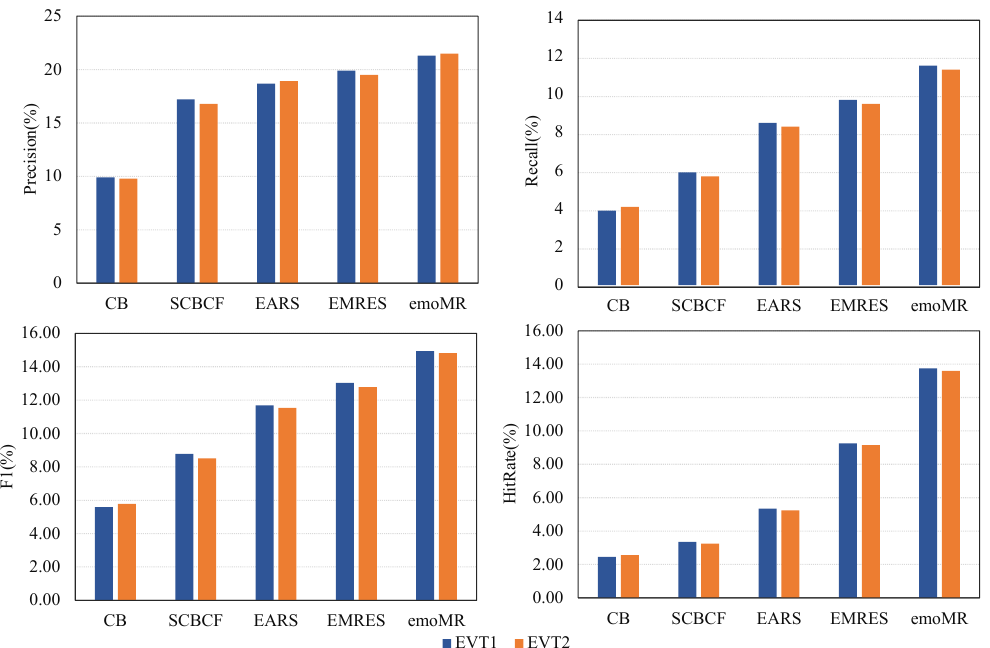
Figure 11. The performance comparison of the methods in recommending top-10 items during event-related time